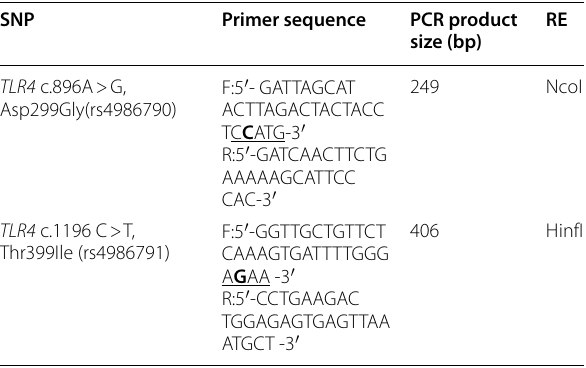
Table 1 Oligonucleotide primer sequences, PCR product sizes, and restriction